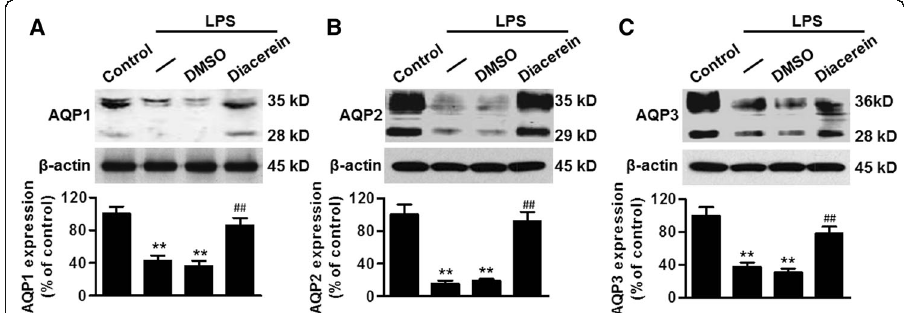
Fig. 4 Diacerein attenuated downregulation of renal AQP expression in endotoxemic mice. a - c Protein expression of aquaporin 1 (AQP1) ( a ), AQP2 ( b ) and AQP3 ( c ) in kidney was determined by western blotting. Diacerein significantly inhibited lipopolysaccharide (LPS)-induced decrease of AQP1, AQP2 and